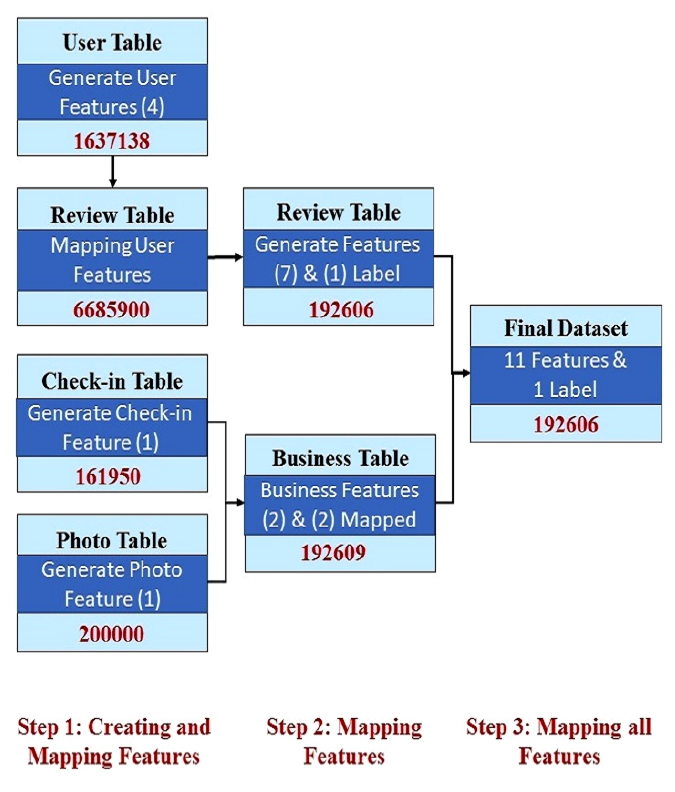
Figure 3. Flow chart of step performed for creating the